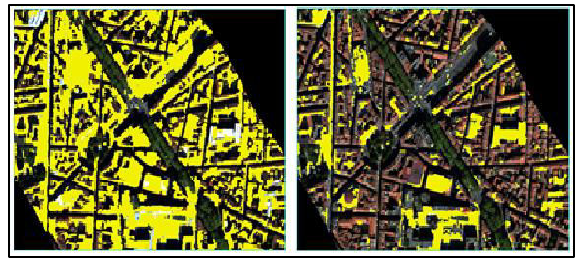
Figure 4. Urban objects identification using textural attribute (texture mean)